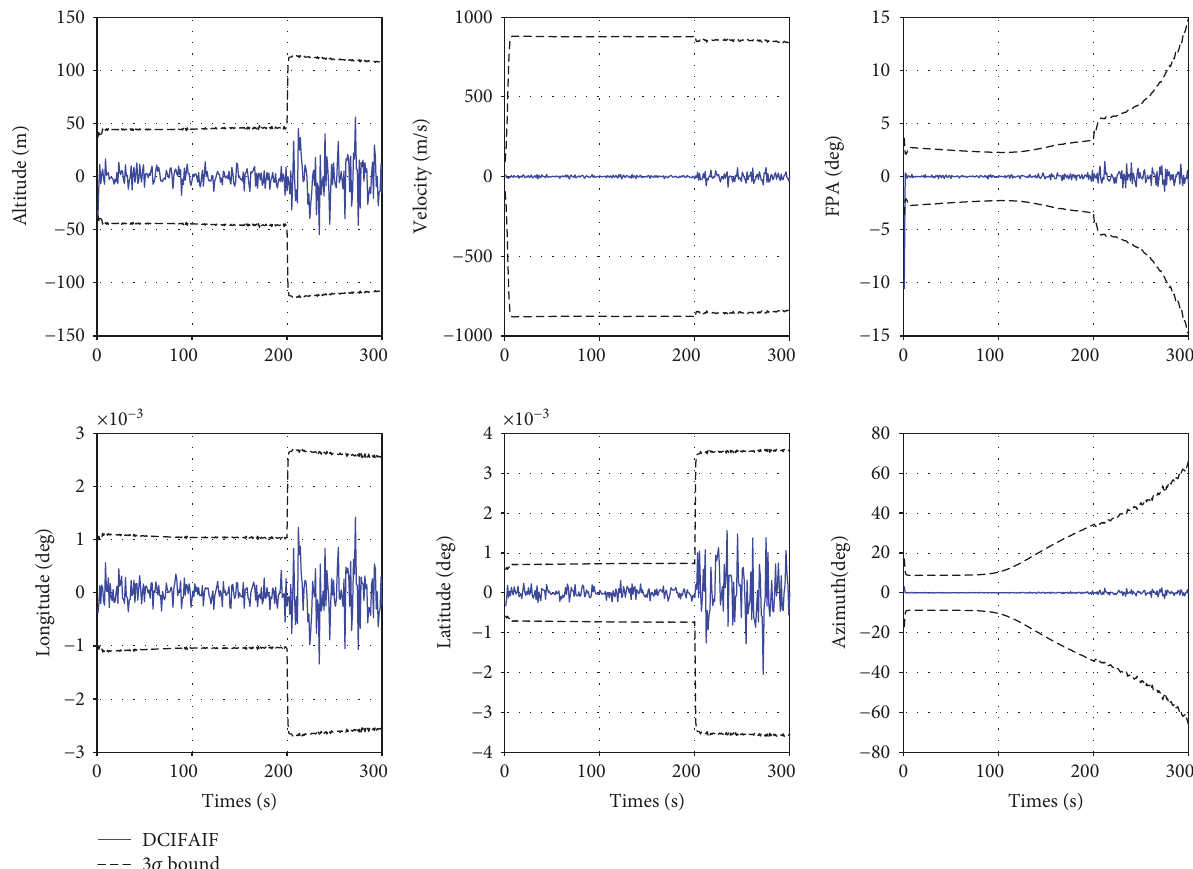
Figure 9: State estimate errors and 3 σ bounds for DCIFAIF when fault